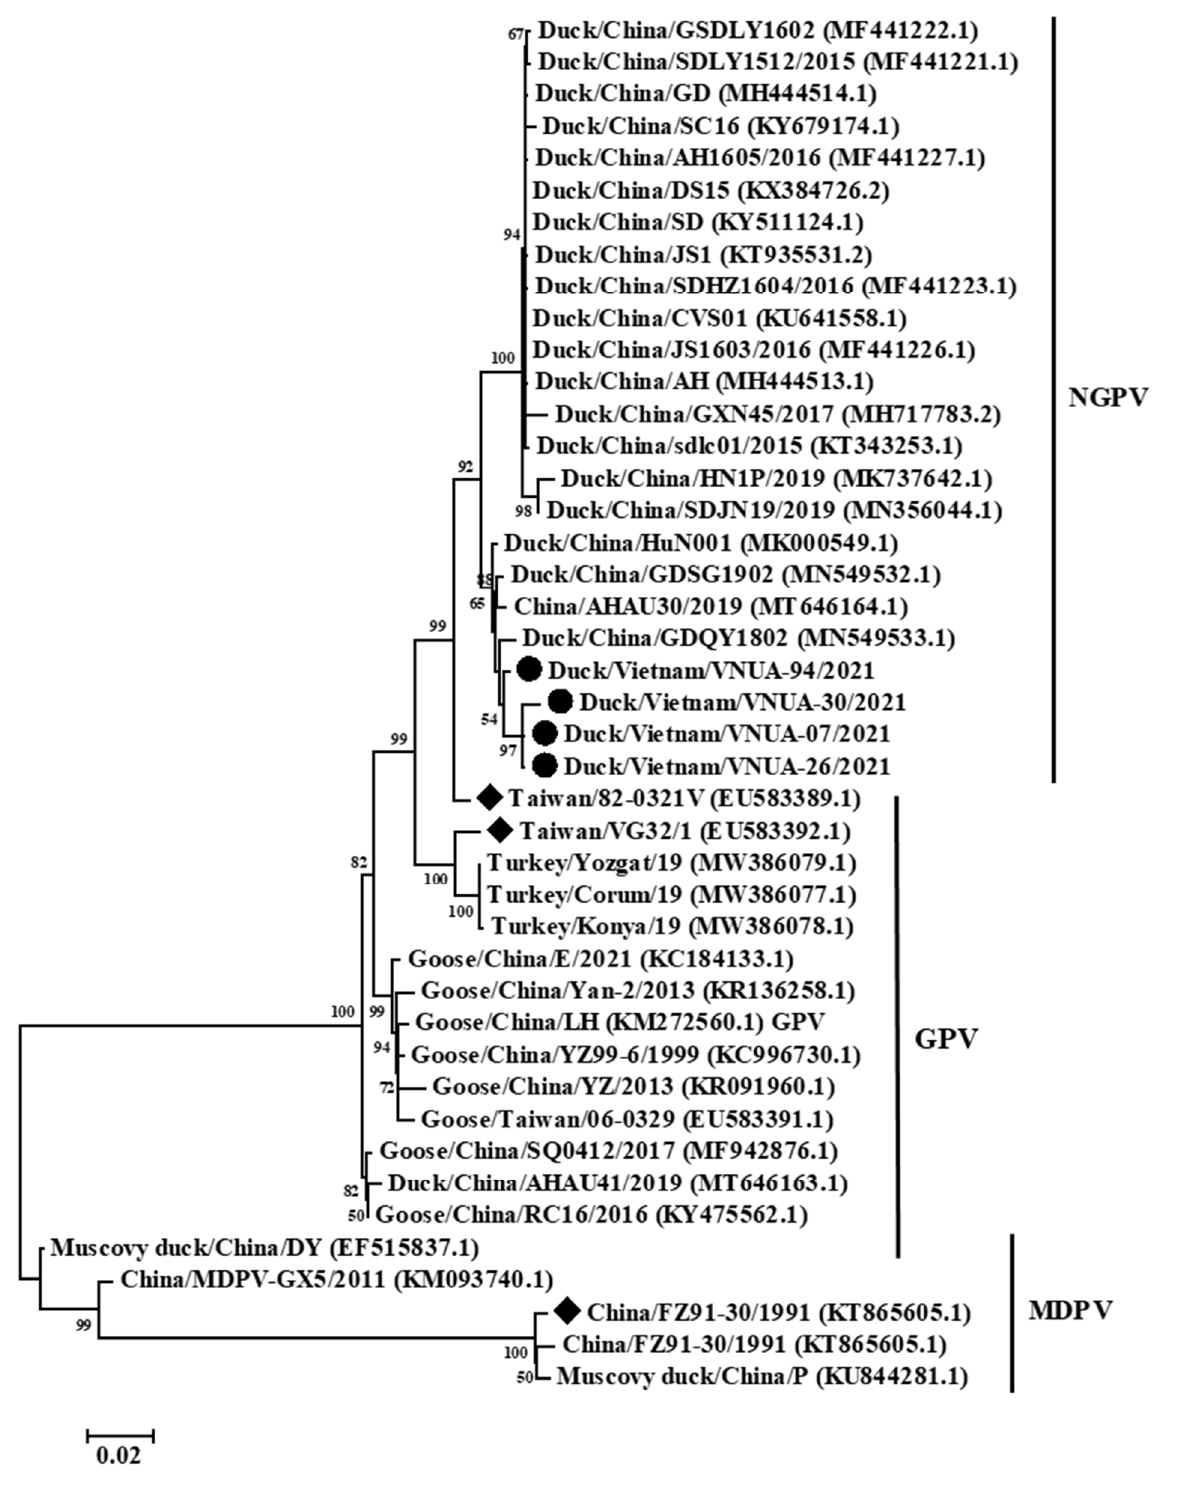
Figure 3. Phylogenetic trees of the full-length Cap gene (2199 bp) sequences of Vietnamese parvovirus strains compared with those available in GenBank. GenBank sequences are indicated by the country name/accession number. The maximum likelihood method in the MEGA6 software was used to establish phylogenetic trees (1000 bootstrap replicates). Numbers at each branch point indicate bootstrap values ≥ 50% in the bootstrap interior branch test. The current Vi-etnamese and vaccine strains are indicated by circles and diamonds, respectively.